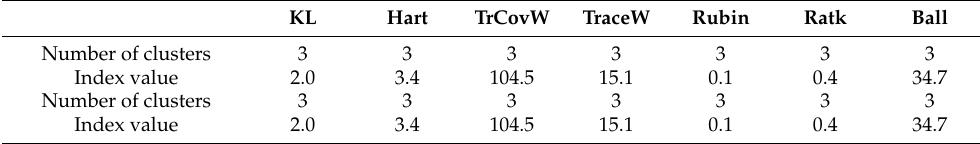
Table 2. Indices compared by Nbclust to determine the best number of clusters. KL: maximum value of the index [33]; Hart: maximum difference between hierarchy levels of the index [34]; TrCovW: maximum difference between hierarchy levels of the index [35]; TraceW: maximum value of absolute second; Rubin: minimum value of second differences between levels of the index [36]; Ratk: maximum value of the index [37]; Ball: maximum difference between hierarchy levels of the index [38].